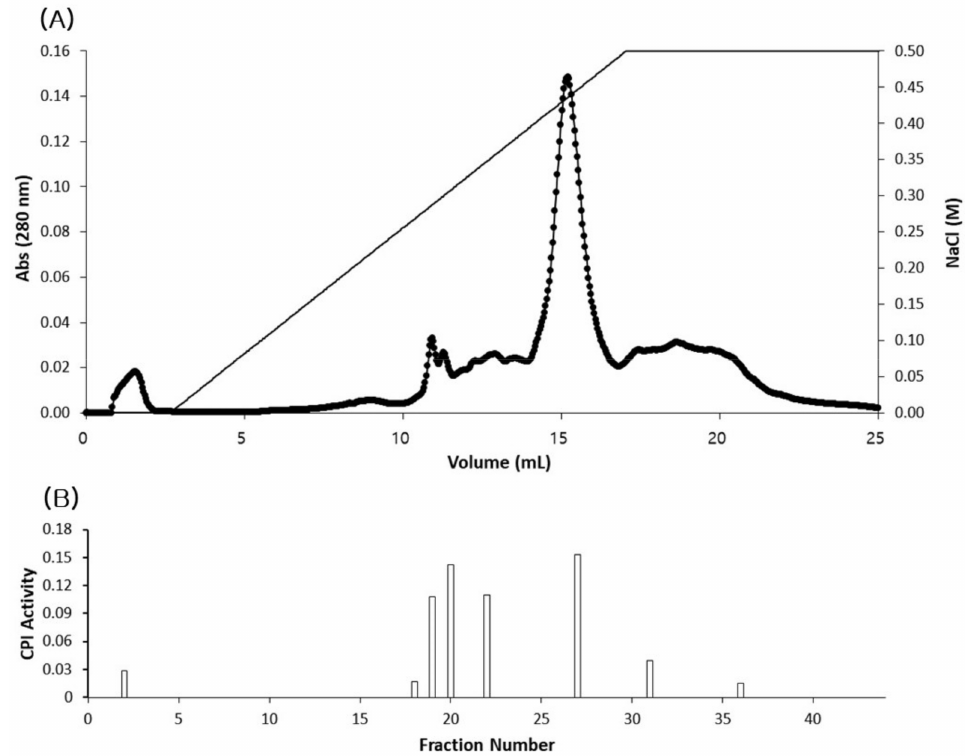
Figure 5. Fractions with CPI activity obtained from the affinity chromatography were pooled and subjected to ion exchange FPLC column (mono Q) ( A ). The proteins were eluted with a 0–0.5 M NaCl gradient. CPI activity was analyzed for fractions obtained from the ion exchange column, and the fractions with distinct levels of CPI activity are shown ( B